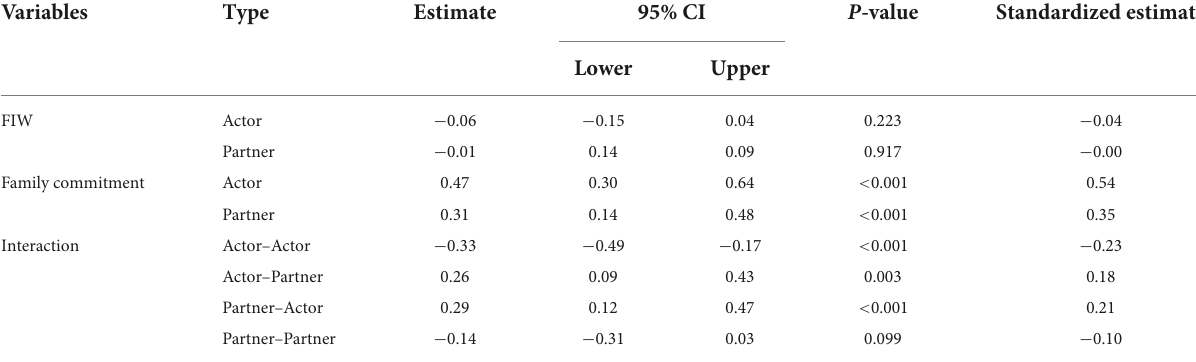
TABLE 4 The moderating model for predicting family